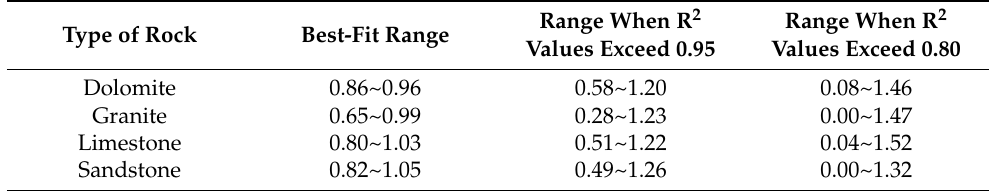
Table 2. Range of m values with different R 2 values.